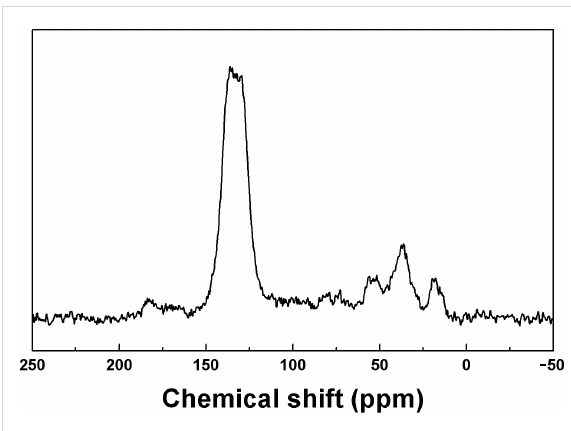
Figure 1: 13 C CP/MAS NMR spectrum of SugPOP-3 .